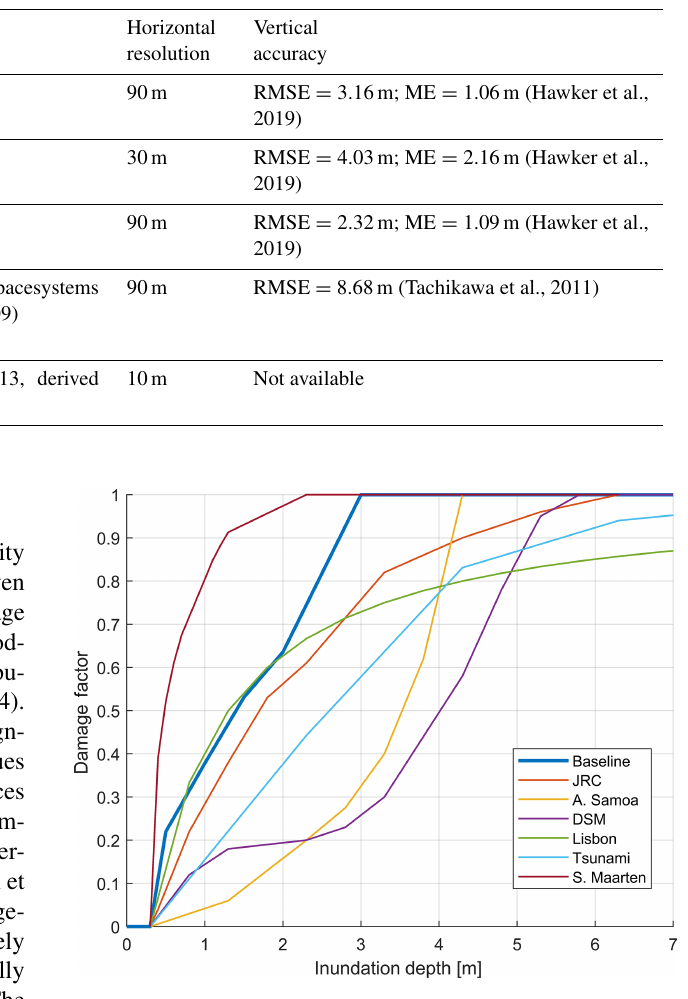
Figure 4. Overview of the different DDFs investigated in the study, including concave (Baseline, JRC, Lisbon, S. Maarten and Tsunami) and convex (American Samoa and damage scanner model, DSM) types. See Table 3 for details of